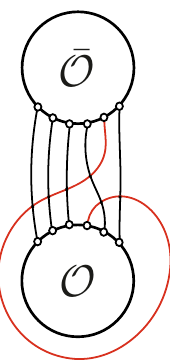
Figure 12 . The two point function of two spiraled states. The red lines correspond to the prop- agation of a (cid:30) 2 (cid:12)eld which is taken to be an excitation over the reference state made out of (cid:30) 1 , represented by the dark lines. The Feynman graph corrections wrapping the external operators have a con(cid:12)guration of a spiral.